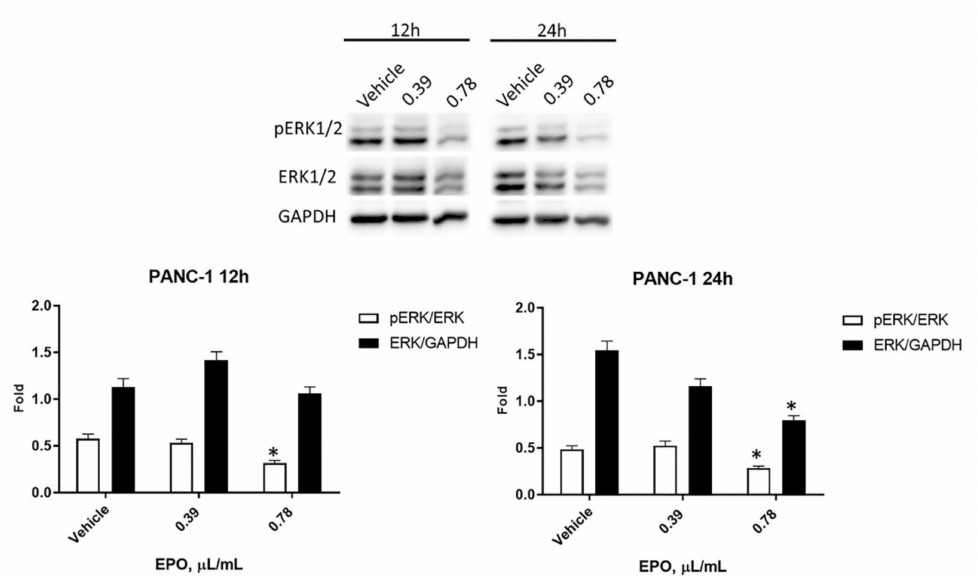
Figure 7. Evaluation of EPO effect in PANC-1. Western blot analysis of pERK and ERK levels in PANC-1 cells after 12 and 24 h treatment with EPO. ERK protein expression was normalized to GAPDH protein expression used as loading control; pERK protein expression was normalized to ERK protein expression. Densitometric values shown are the mean ± SD of three separate experiments. * p < 0.05 treated vs. vehicle cells.